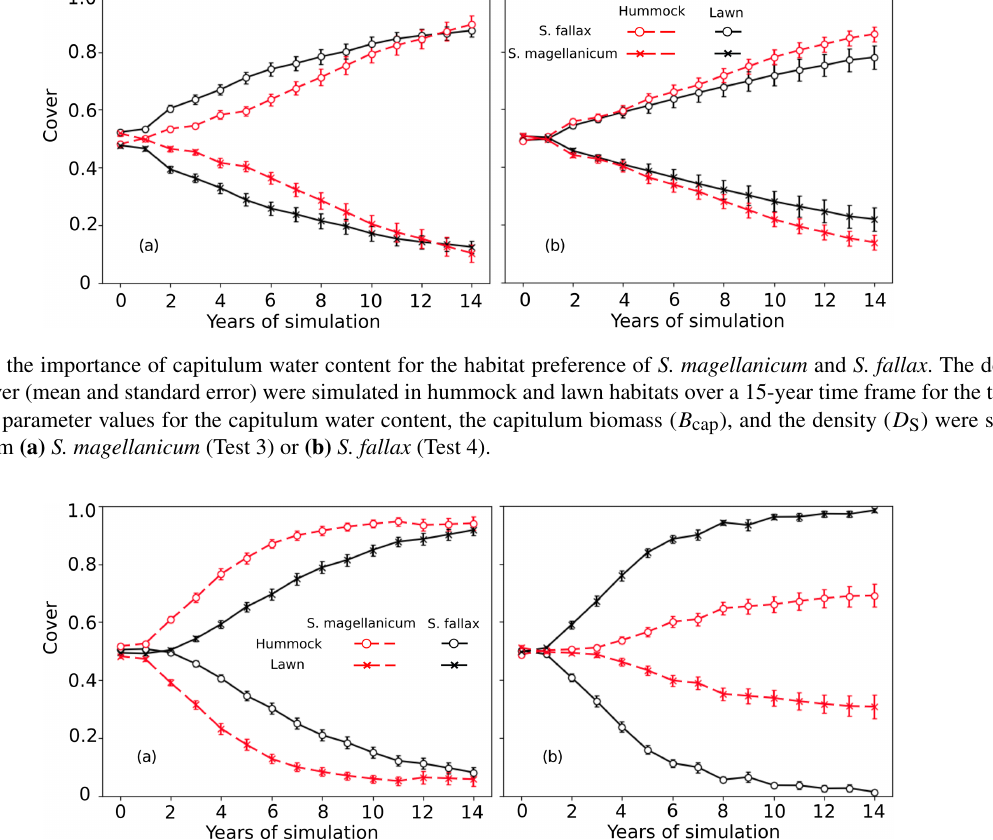
Figure 4. Testing the importance of parameters regulating net photosynthesis and shoot elongation for the habitat preference of S. magellan- icum and S. fallax . The annual development of the relative cover (mean and standard error) of the two species was simulated for hummock and lawn habitats over a 15-year time frame. For both species, the parameter values (i.e. P m20 , R s20 , α PPFD , and H spec ) were set to be the same as those from (a) S. magellanicum (Test 5) or (b) S. fallax (Test